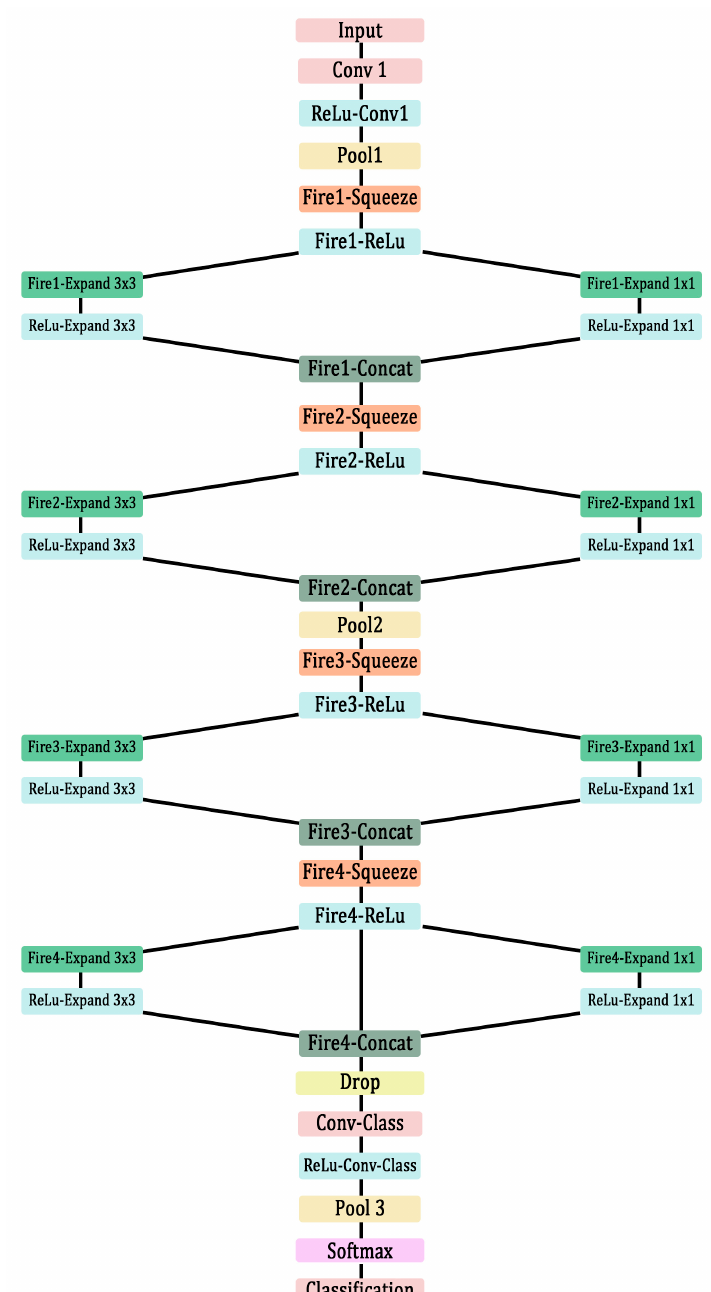
Figure 2. Architecture of SqueezeNet ‐ based CNN.